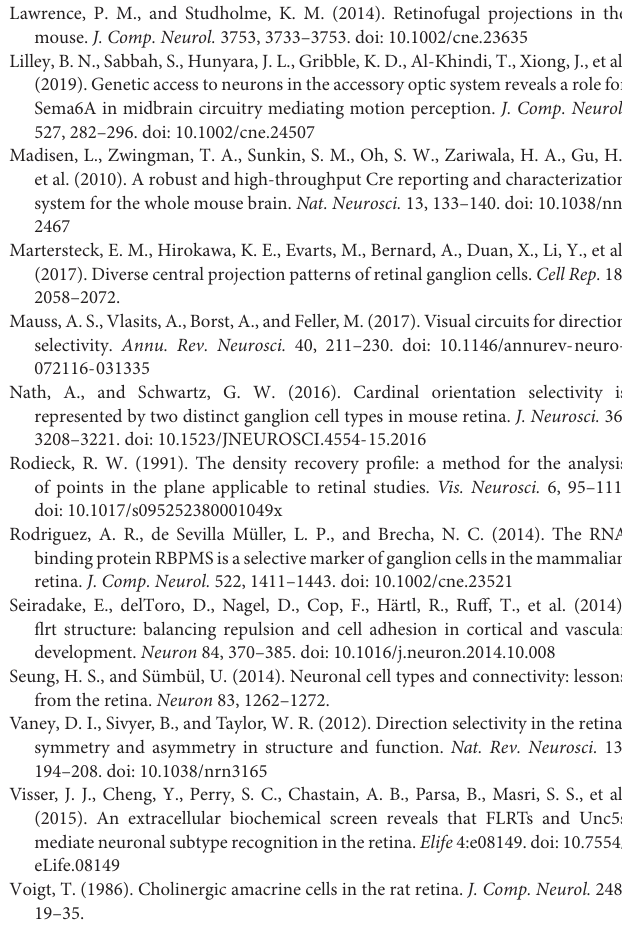
ganglion cell layer. Bottom: percentage of Flrt3 + cells among RGCs. Scale bar = 25 µ m. (C,D) Same figures as (A,B) , but with Flrt2-LacZ mice. White asterisks indicate Flrt2 + RGCs. (E,F) Retina sections from Flrt2-LacZ and Flrt3-LacZ mice, respectively, with Xgal staining at different developmental time points. Supplementary Figure 2 | Flrt3-CreERT2 expression matches Flrt3 LacZ expression in the brain. (A) Coronal brain slices of Flrt3-CreERT2 ; Tom ± mice, from anterior to posterior. (B) Zoomed in view of different regions from (A) (dashed boxes). (C) Comparison between Flrt3-Tom and Flrt3/LacZ mice. (D) Algorithm showing how the DRP values were calculated. Rectangular regions of the retina were selected to create an autocorrelogram. Annuli around the center of the autocorrelogram were drawn to calculate the binned density from the center to the periphery and represented as the density recovery profile. (E) Random distribution of Flrt3-amacrine cells. Left panel: Flrt3-amacrine cell distribution in a ROI. Each dot represents a Flrt3 + amacrine cell. Right panel: Density recovery profile of Flrt3 + amacrine cells showing a random distribution. Graph shows mean value ± SEM. Line represents a 7th order fit of the mean values. Shaded area is the 99% confidence interval. N = 14 ROIs from 4 retinas and 2 mice. s Supplementary Figure 3 | Immunostainings showing some overlap with other known RGC markers. (A–F) Staining for various known markers: Safb1, SMI32, Calbindin, Bm3c, Parvalbumin, and CART (blue) in Flrt3-RGCs (Tom, magenta) and RBPMS (green). The blue arrowhead shows an example of RGC that co-localizes with Flrt3 and the different markers. (G) Quantification of the percentage of Flrt3-RGCs expressing the markers shown in (A–F) . Mean value ±